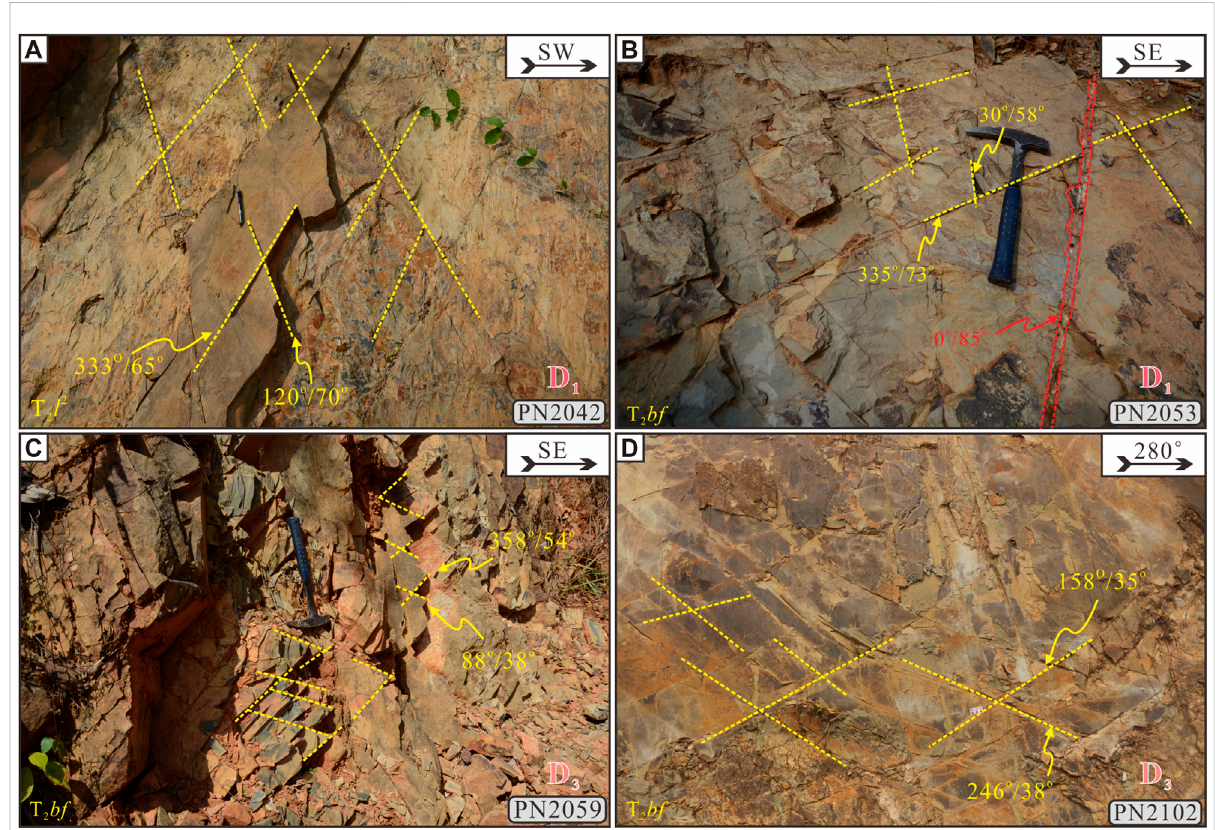
FIGURE 3 Fieldphotographs ofconjugatejointsdevelopedintheD 1 andD 3 structures intheYFTB. (A) Conjugatedjointsdevelopedinthesiltstonesofthe Triassic Lanmu Formation at PN2042 documenting NE – SW-oriented compression. (B) Conjugated joints developed in the siltstones of the Triassic Baifeng Formation at PN2053 indicating NE – SW-oriented compression. (C) Conjugated joints developed in the siltstones of the Triassic Baifeng Formation at PN2059 demonstrating NW – SE shortening. (D) Conjugated joints developed in the siltstone of the Triassic Lanmu Formation at PN2102 indicating NW – SE